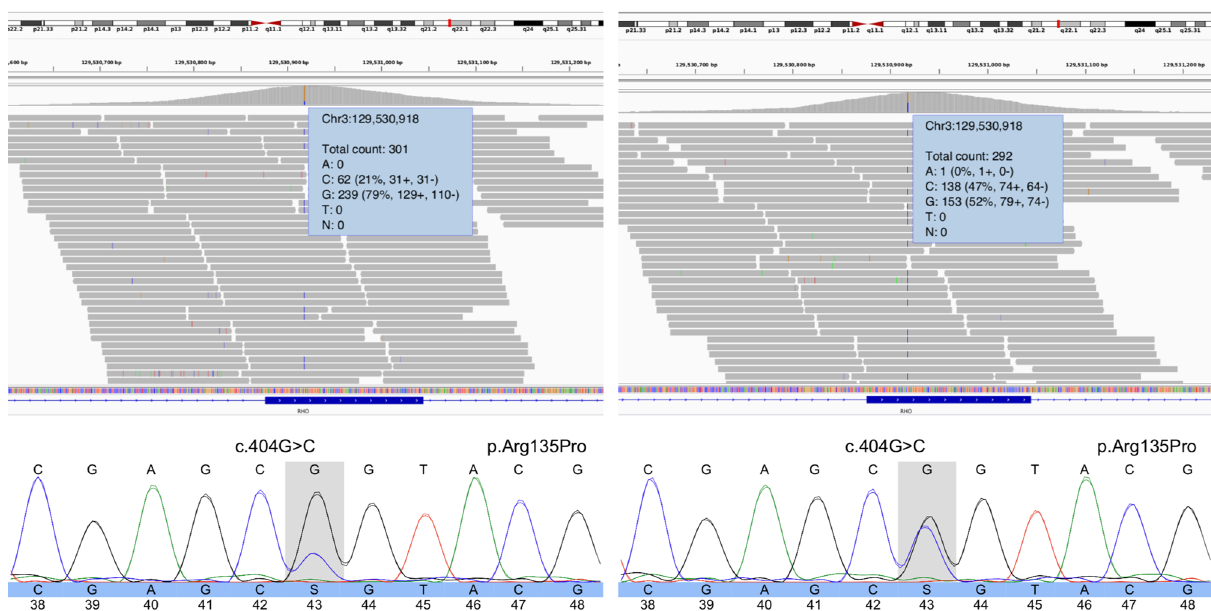
Figure 4. Genomic testing. (Left) Whole exome sequencing reads visualized in the Integrative Genomics Viewer (IGV), showing the RHO variant c.404G > C p.(Arg135Pro) in a mosaic state (variant allele frequency [VAF] of ~ 21%) in the mother (II.1) (top). Sanger sequencing confirmation of the mosaic variant is shown at the bottom. (Right) IGV view of the RHO variant c.404G > C p.(Arg135Pro) in a heterozygous state (VAF: ~ 47%)